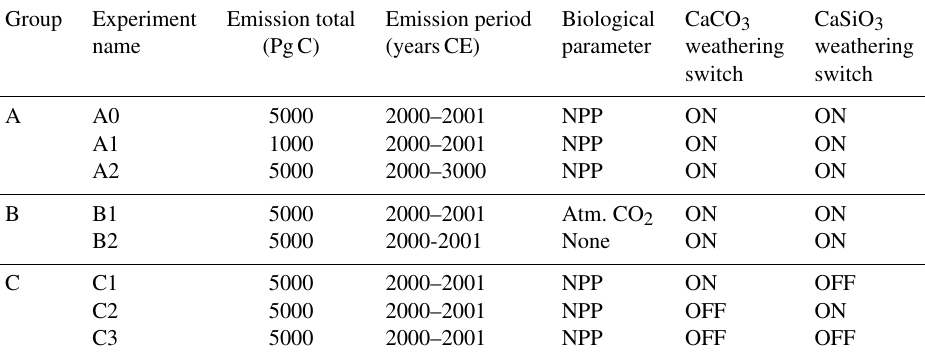
Table 2. Description of each experiment carried out in this study. The emission total is the total amount of carbon emissions; the emission total is divided equally among the number of time steps during the emission period. For the biological factor, “NPP” refers to Eq. (9), “Atm. CO 2 ” to Eq. (10), and “None” signifies that this part of the weathering scheme is ignored. Finally, when the CaCO 3 switch is OFF, the amount of carbonate weathering produced by the model is set to its pre-industrial value for the duration of the simulation, similarly for when the CaSiO 3 switch is